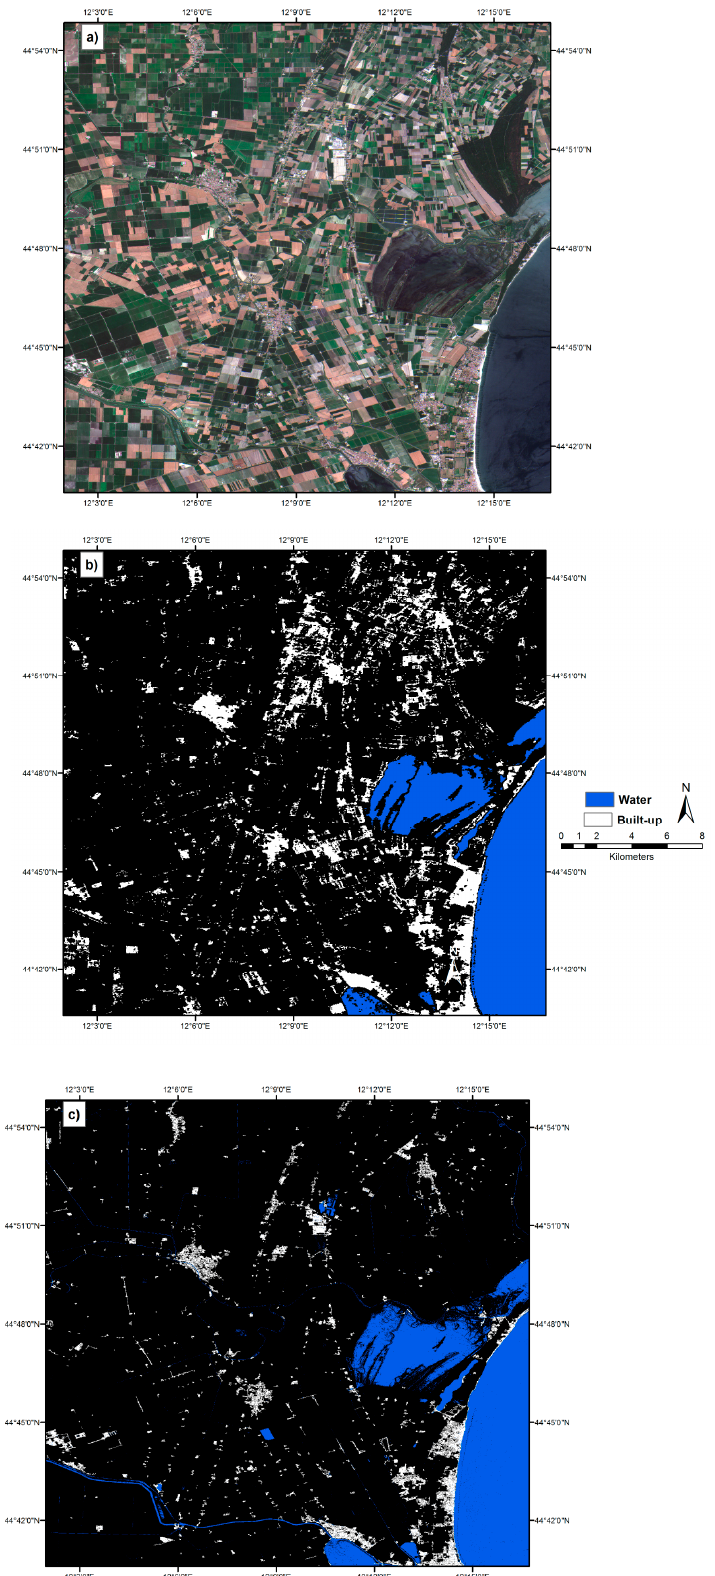
Figure 5. Detailed view of an area from the Sentinel-2 image in natural colors ( a ) and the two classification outputs (built-up and water classes) obtained with Landsat ( b ) and Sentinel-2 ( c ) (all three figures are at the same scale).